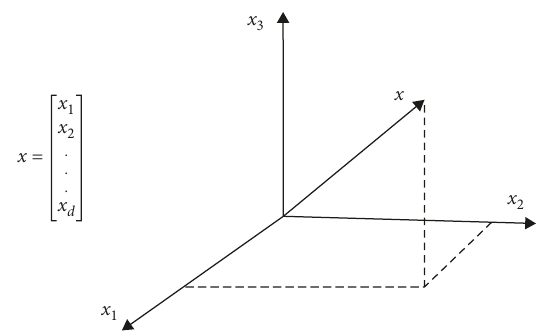
Figure 4: A vector created using biometric values.